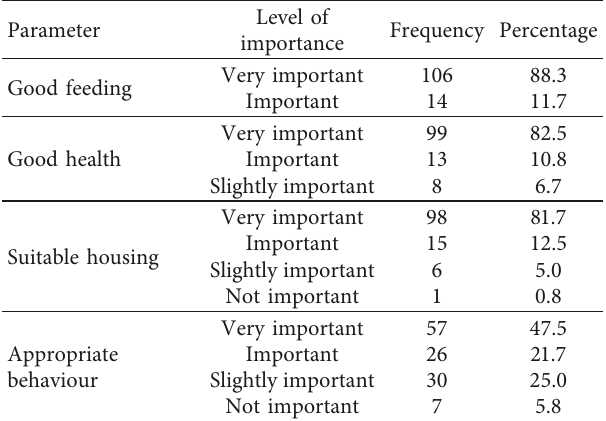
Table 6: Perception of broiler welfare by respondents (%).